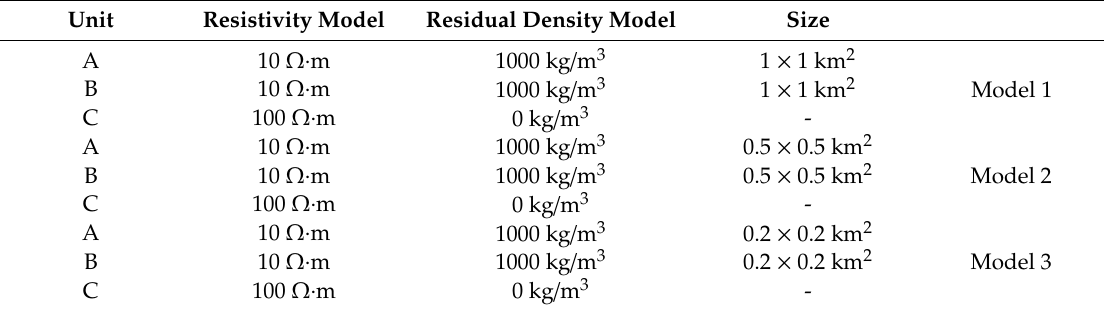
Figure 7. The true model of MT and gravity methods. Model 1 ( a , b ); Model 2 ( c , d ); Model 3 ( e , f ); Resistivity models ( a , c , e ) ; Density models ( b , d , f ). Table 3. The resistivities and residual densities of the synthetic model.